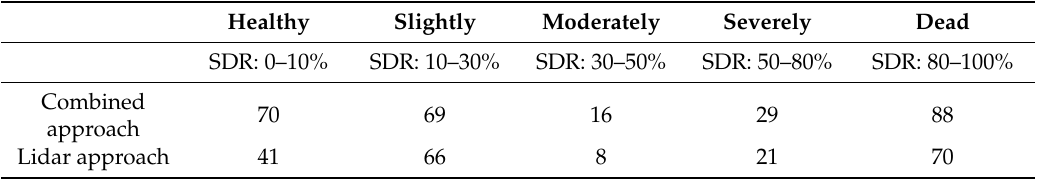
Table 5. Comparison of the lidar and combined approach on the classification accuracy of di ff erent damaged degrees. Healthy Slightly